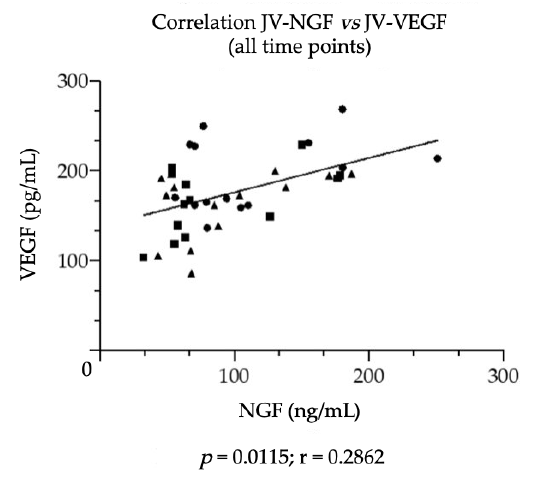
levels of NGF and VEGF in the foal’s JV at each time point ( p = 0.0115; r = 0.2862).